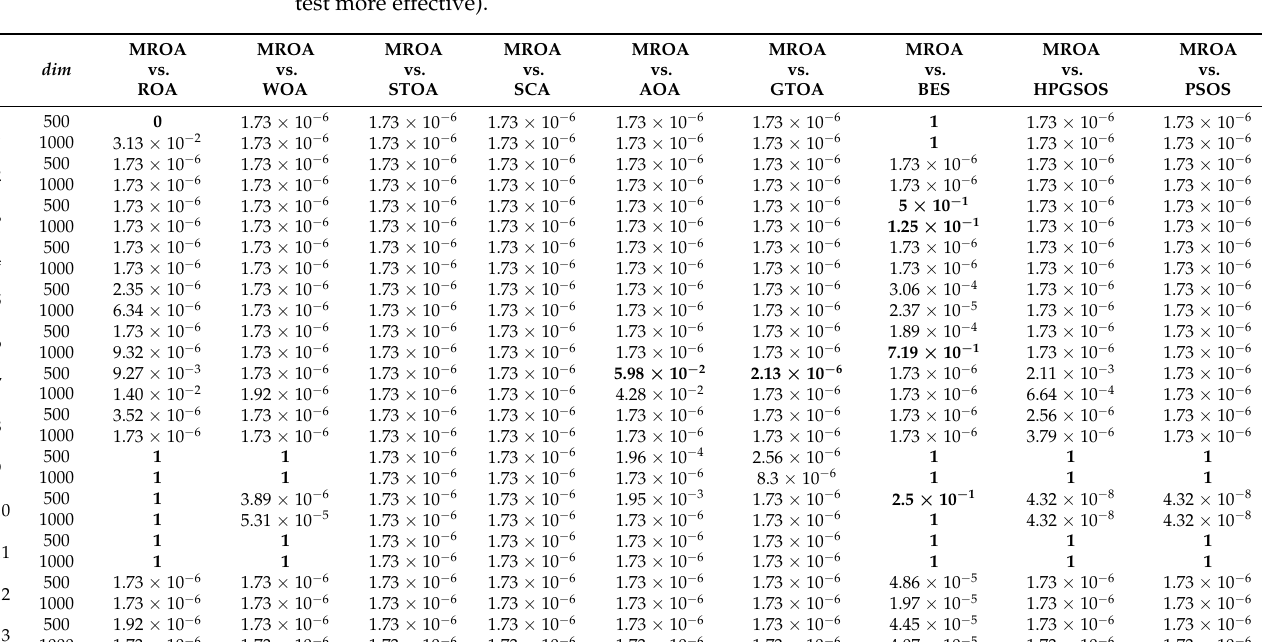
Table 6. The Wilcoxon signed-rank test results between MROA and other metaheuristic algorithms on test functions (F1–F13) in high dimensions (run 30 times). (Bold makes the Wilcoxon rank-sum test more